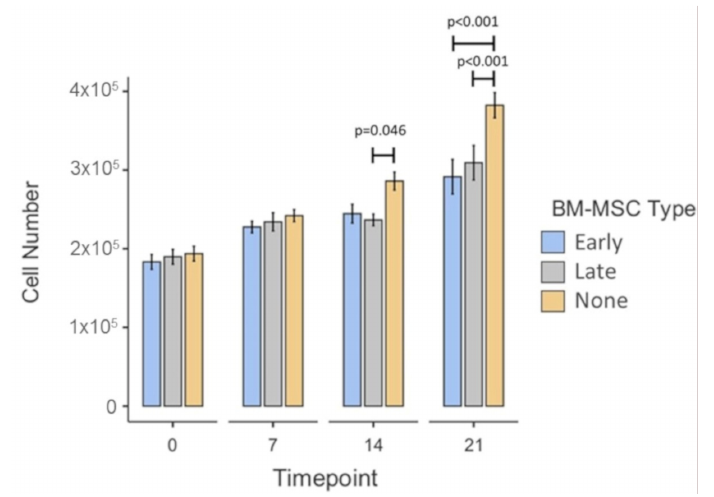
Figure 8. Mean chondrocyte number in scaffolds taken from the co-culture model at the four timepoints. Error bars represent the standard error of the mean. Significant differences are indicated by horizontal